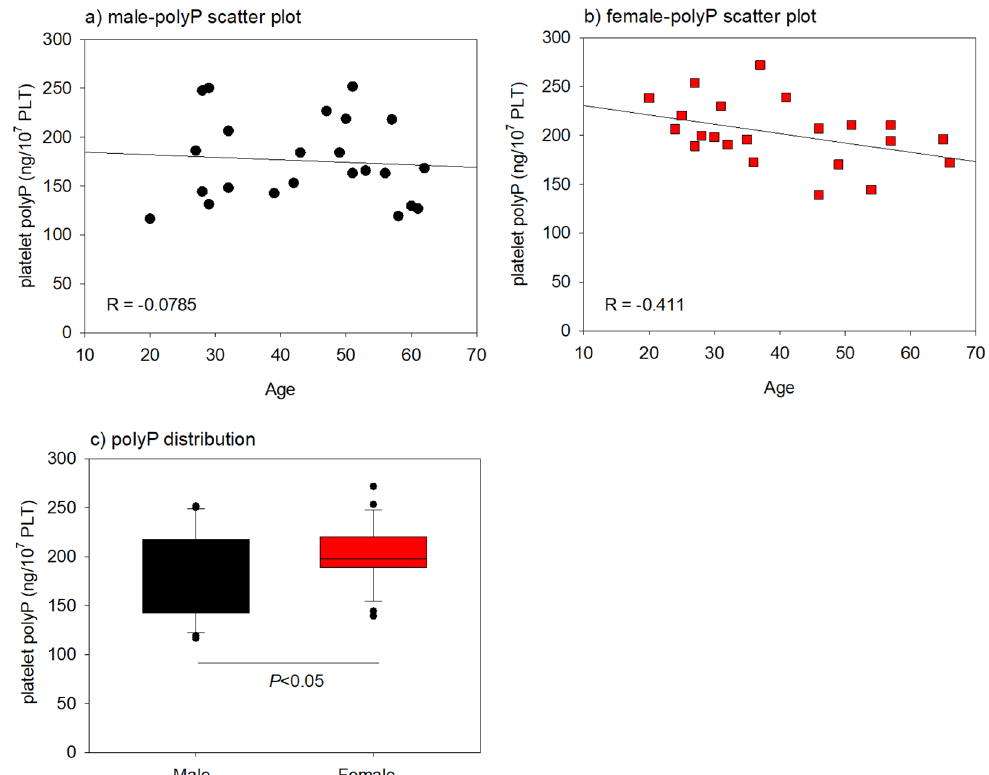
Figure 4. Scatter plots for age vs. platelet polyP levels in male and female groups. ( a ) A scatter plot of male group; a very weak correlation (R = − 0.0785) was observed. ( b ) A scatter plot for female group; a moderate correlation (R = − 0.411) was observed. ( c ) Comparison of platelet polyP levels between male and female groups; a significant difference was obtained ( n = 23 for each).